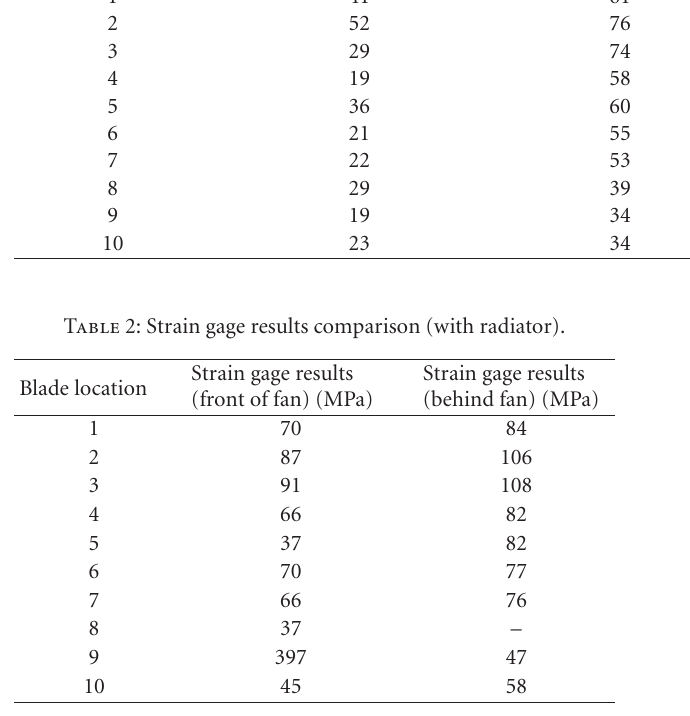
Figure 7: Strain gage locations on the fan